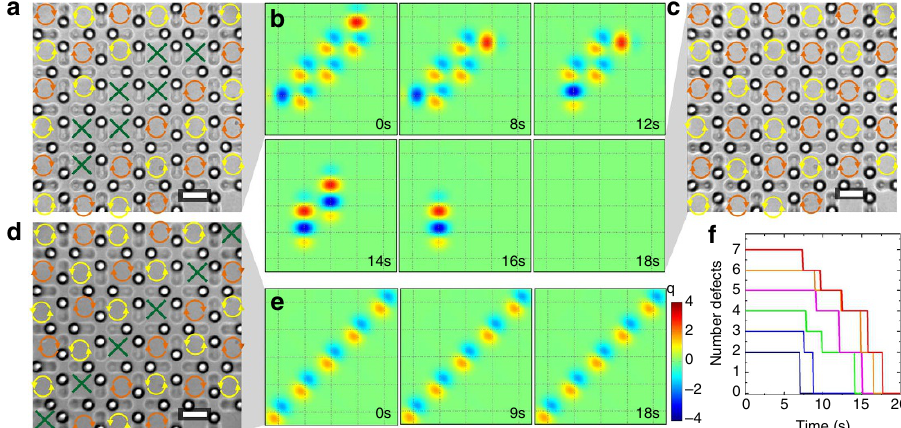
Figure 3 | Defect annihilation and dynamics. ( a ) Microscope image showing a square ice state prepared with a pair of q ¼ ± 2 charged defects separated by two parallel strings composed of seven achiral cells (green crosses). The string is introduced in a ground state region with cells that possess defined clockwise (orange arrows) or counterclockwise (yellow arrows) chirality. ( b ) Upon application of an external field ( B ¼ 18.5mT), the defect pair rapidly annihilates via a sequence of particle flips, restoring the ground state after 18s ( c ). ( d ) Square ice state in which a single grain boundary of achiral cells separates two incompatible ground state regions. Scale bars, 20 m m for all images. In e , the time evolution of the defect line when subjected to the same field condition as in b shows no change because ground state recovery requires the high-energy cost of flipping all the spins in one of the two regions. ( f ) Stepwise defect reduction as the field is applied, reflecting the consecutive spin flipping process that leads to the ground state in b